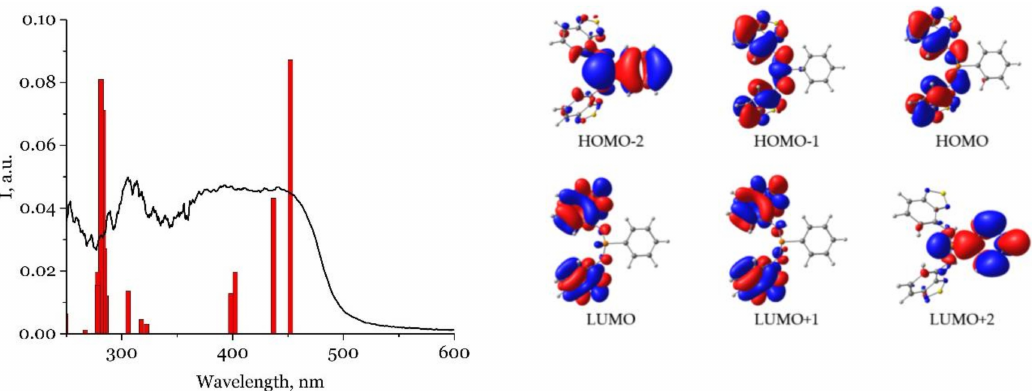
Figure 14. UV-vis spectrum and calculated transitions (left) and frontier molecular orbitals (right) of H 2 L based on TD-DFT at B3LYP / def2TZVPP level (isovalue = 0.02